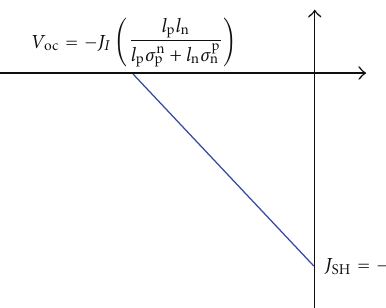
Figure 3: J - V characteristic of an ideal thin-film solar cell with the new expression for the x axis-intercept point V oc